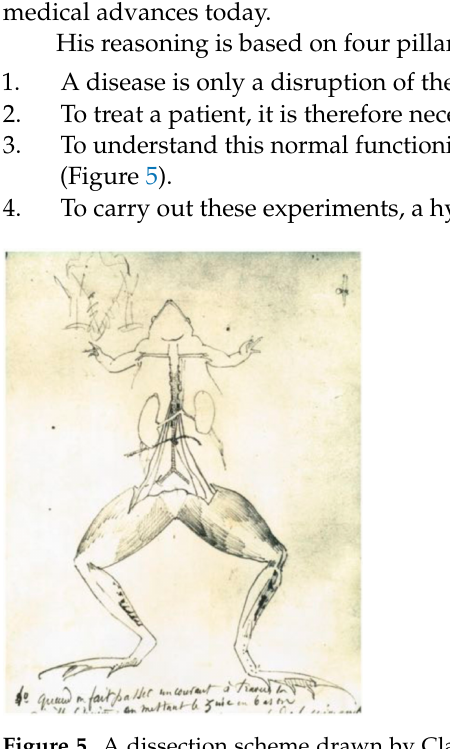
Figure 5. A dissection scheme drawn by Claude Bernard. Mus é e Claude Bernard, Communaut é d’Agglom é ration Villefranche Beaujolais Sa ô ne.